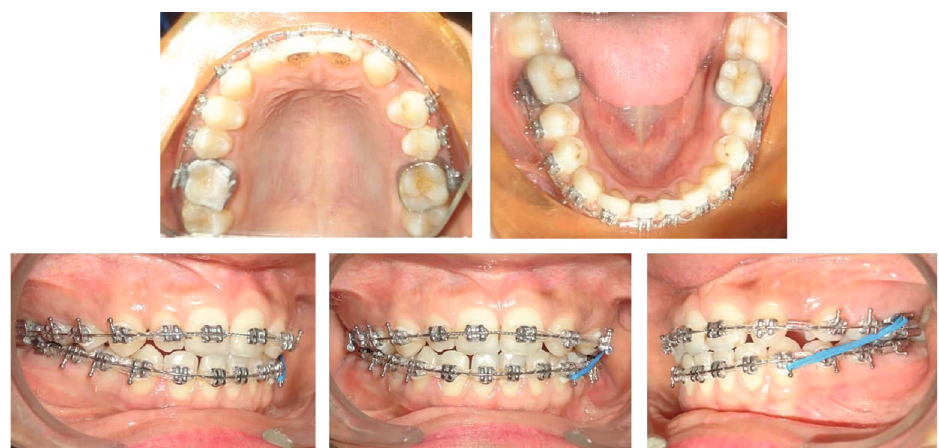
Figure 5: Midtreatment